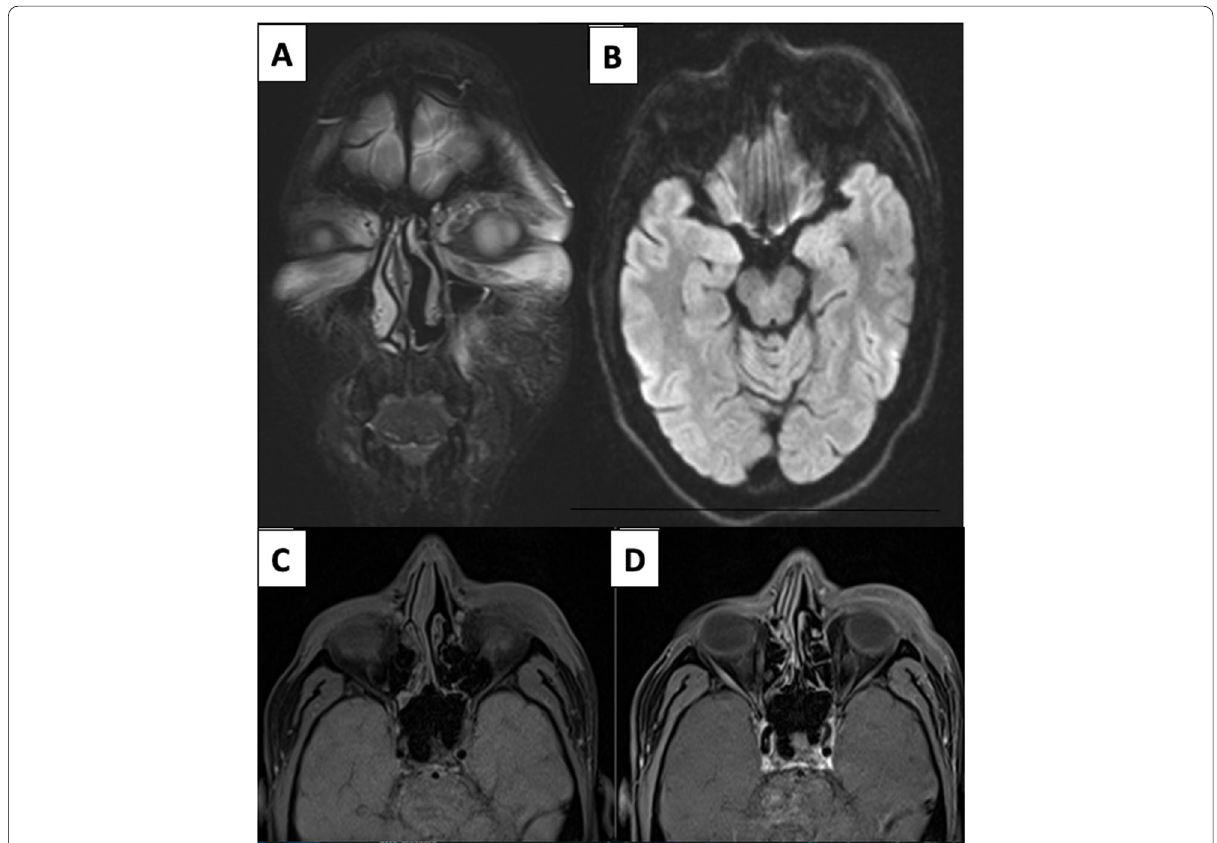
Fig. 4 A Coronal fat sat T2-weighted images show bilateral (L>R) orbital hyperintensities involving preseptal, premalar fat, and frontal scalp tissue on the left side. B Axial DWI shows no evidence of diffusion restriction. C , D Pre- and post-contrast fat sat T1 axial images show no